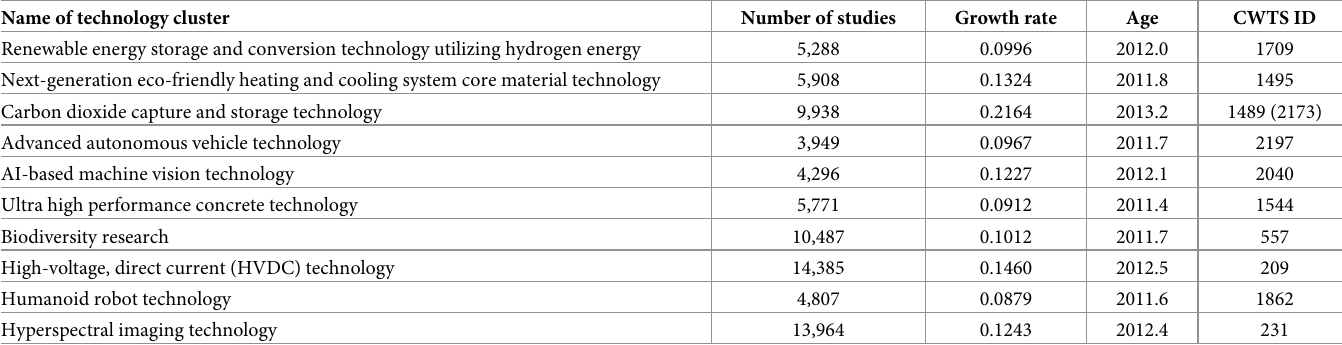
Table 2. Performance of deep learning-based prediction